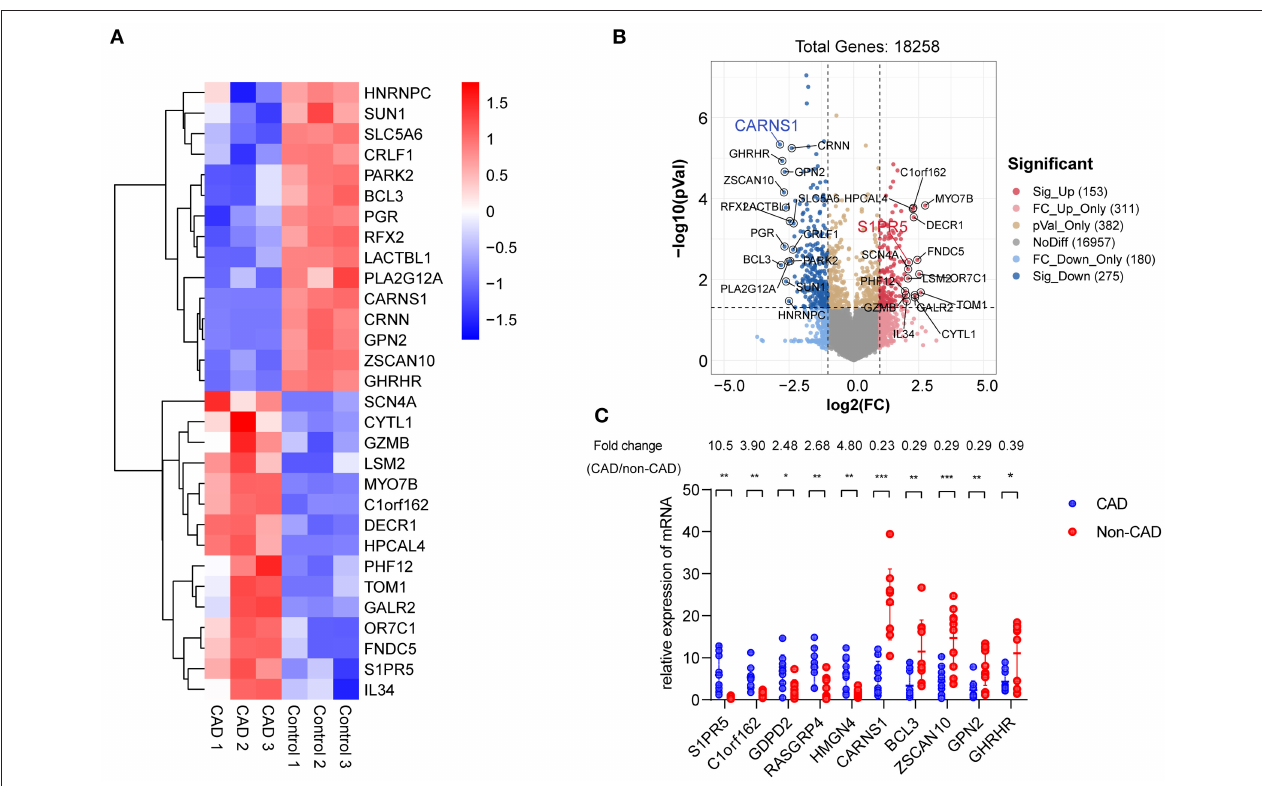
FIGURE 2 | Identification of differentially expressed mRNAs in plasma exosomes derived from CHD patients. (A) Heat map showing hierarchical clustering analysis of mRNAs detected in CHD group and the control group patients. (B) Volcano map showing the distribution of differential mRNAs according to their p -values and fold-changes. Candidates with p < 0.05 and |log 2(fold-change) | ≥ 1 are considered differential. The molecules with the most significant differences are marked on the volcano map. (C) Differential expression of 10 mRNAs was validated in plasma exosomes derived from CHD group and the control group patients using qRT-PCR. Data are presented as means ± SD; significant difference was identified with Student’s t -test. * P < 0.05; ** P < 0.01 and ***P < 0.005; ns, not